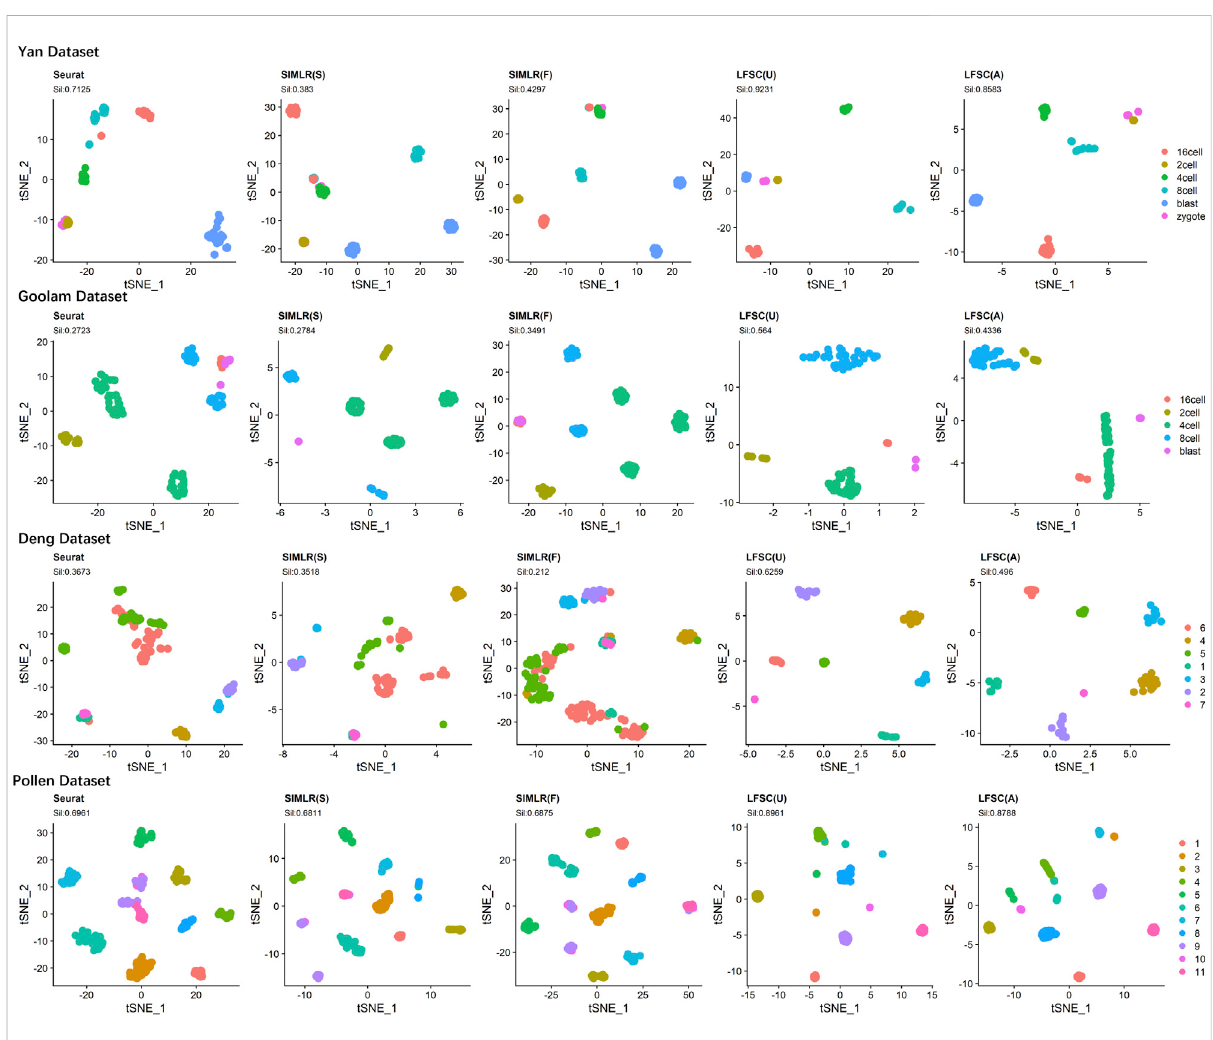
FIGURE 6 t-SNEplotsofLFSCandbaselinemethodswithcorrespondingsilhouettecoef fi cientsandclusteringresultsonfourhighlycon fi dentscRNA-seq